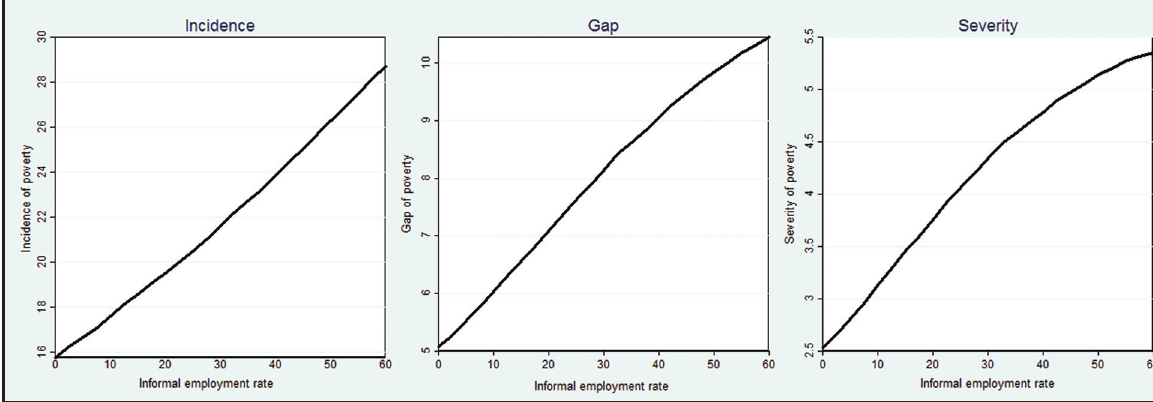
Source : Integrated Household Survey. (NADS, 2014). Note : Data were estimated considering monthly income and informal